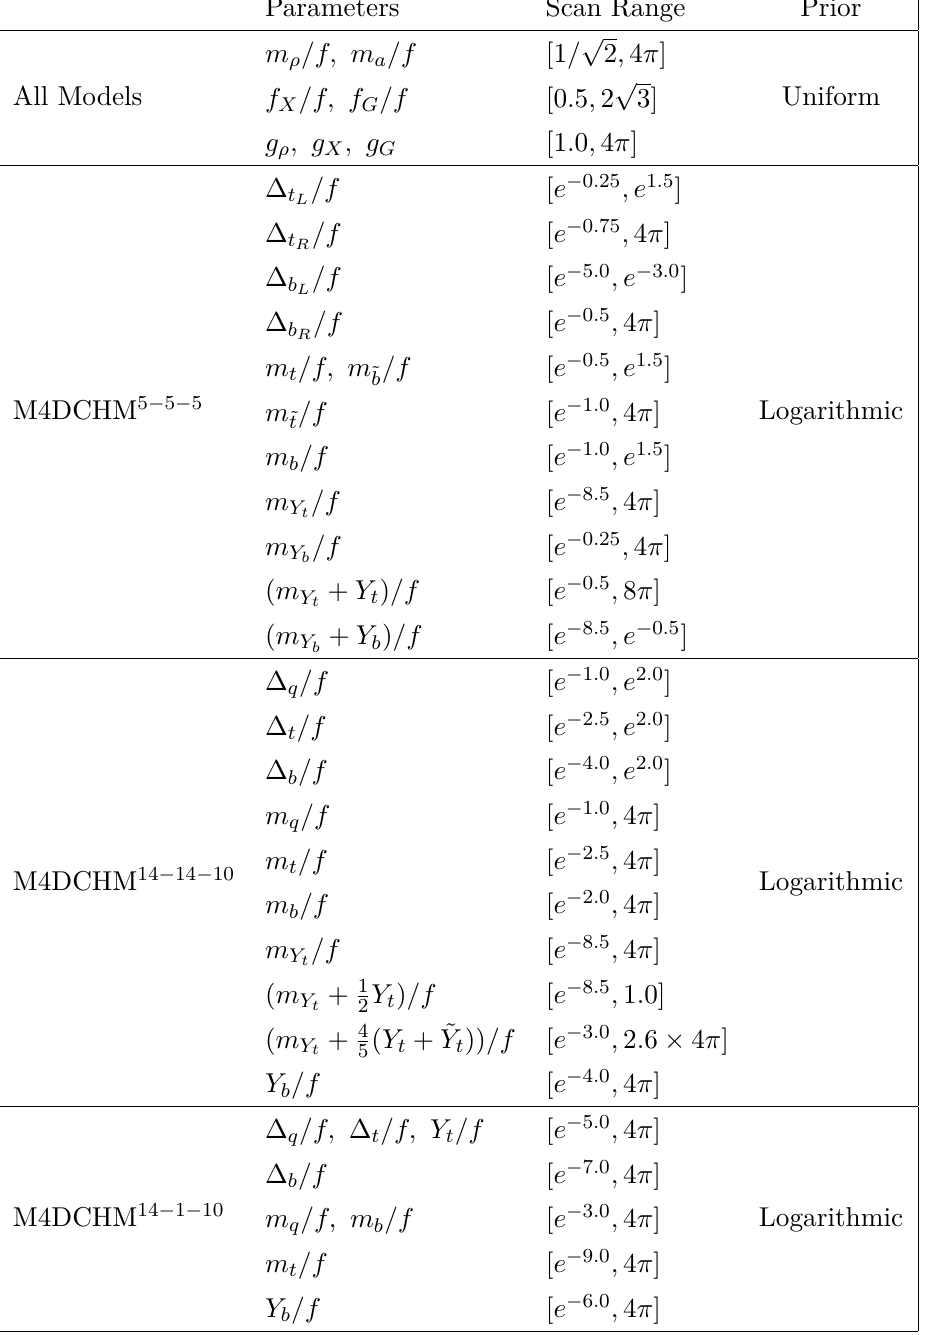
Table 3. Ranges and priors used for the parameters in our scans. The masses m ρ and m a , defined in eq. (2.32), reparameterise the decay constants into a form more suitable for calculating the gauge boson contribution to the Higgs potential. The normalisation factor f is determined after the potential is minimised. Some parameters are subject to further constraints specified in the main